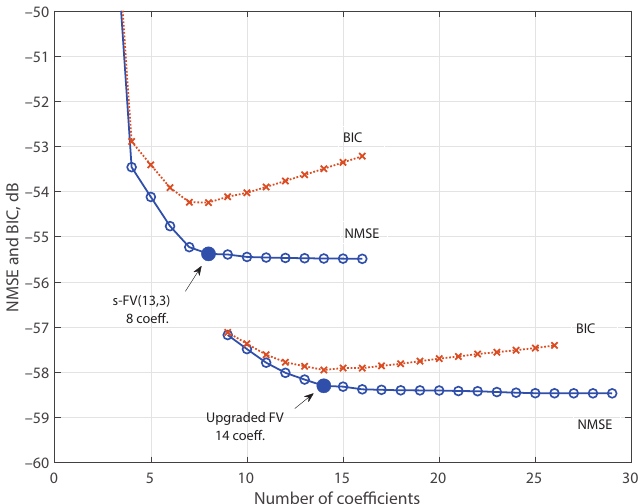
Figure 1. NMSE and BIC vs. number of coefficients for the incomplete s-FV(13,3) and the up- graded models.